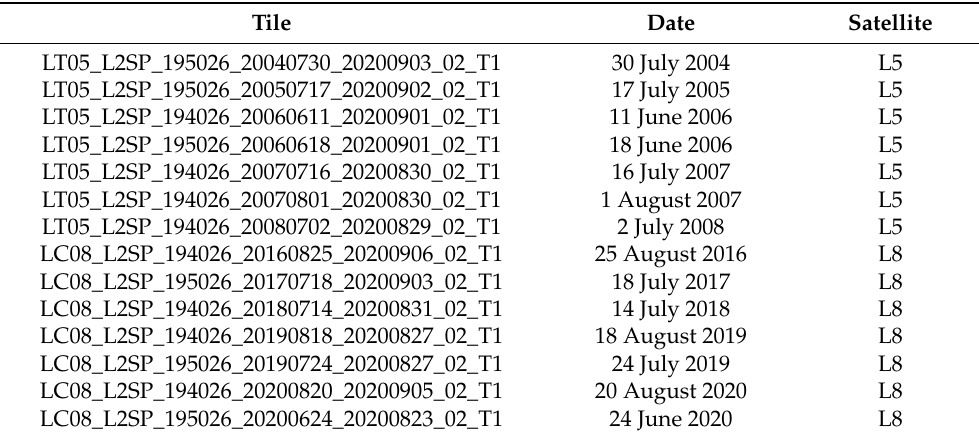
Table A1. Overview of the Landsat tiles used in this study for the calculation of the land surface temperature (LST), surface urban heat island (SUHI), and Normalised Difference Vegetation Index (NDVI). The satellites used are Landsat 5 (L5) and Landsat 8 (L8).